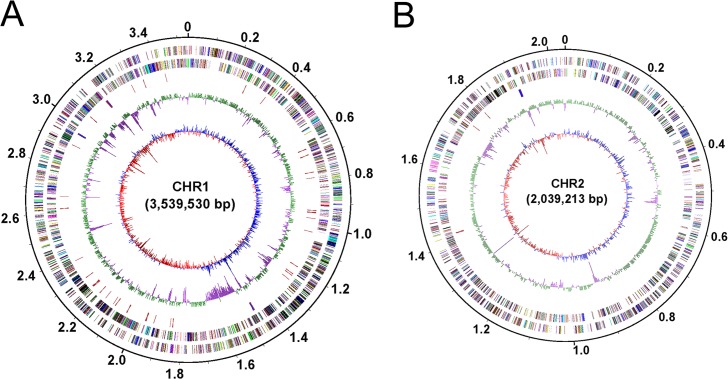
Circular representation of the two replicons of C. gilardii CR3.
(A). Chromosome 1; (B). Chromosome 2. Circles display from the inside outwards, (1) circle 1: GC-skew (G-C/G+C ratio) using a 3 kb window; (2) circle 2: GC-content using a 3 kb window; (3) circle 3: RNA genes; (4) circle 4: COG assignments for predicted CDSs on the minus strand; (5) circle 5: COG assignments for predicted CDSs on the plus strand; (6) circle 6: scale in Mb.